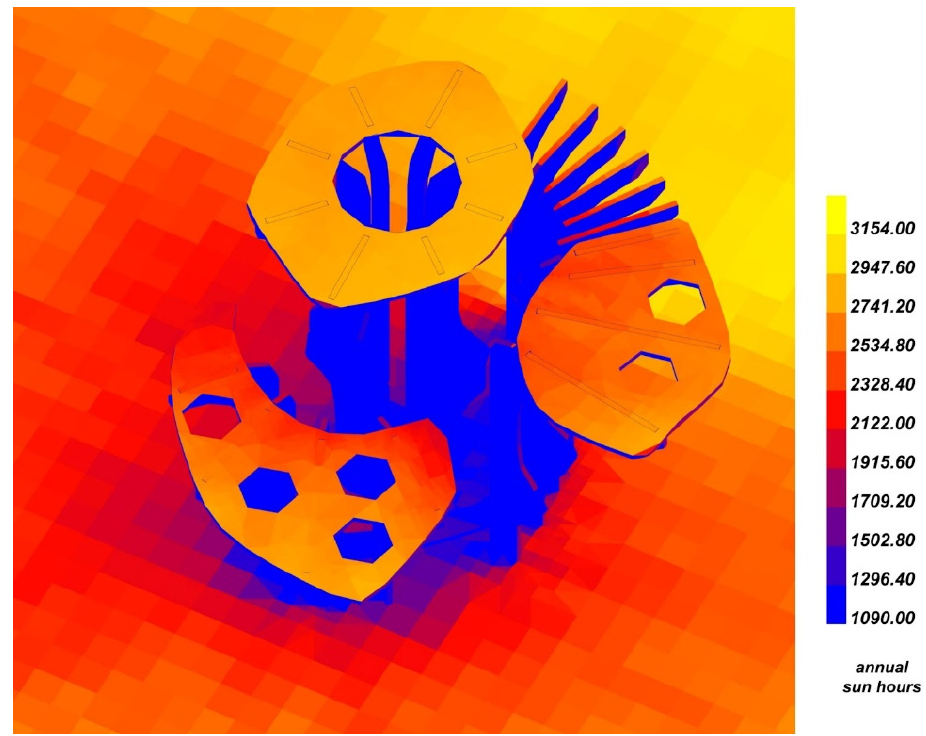
Figure 5. Sun hours analysis of the chosen design.